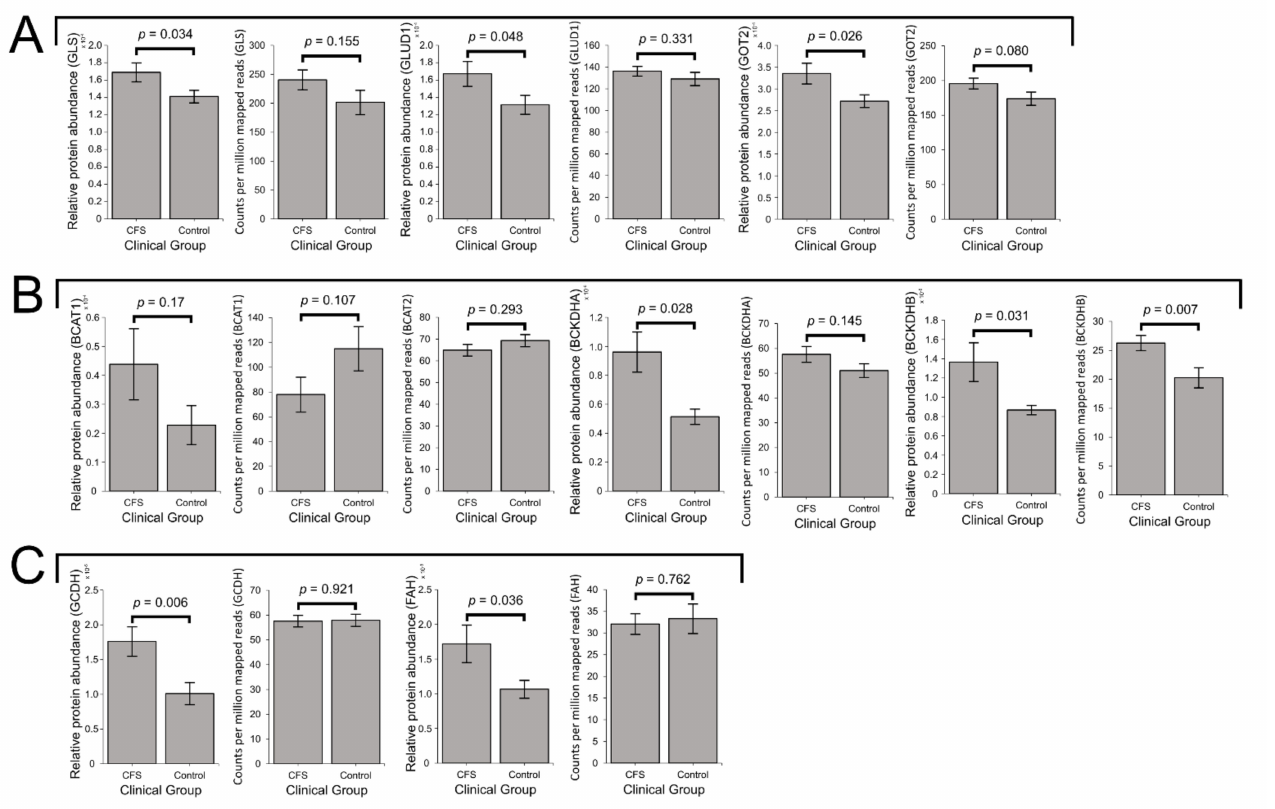
Figure 7. Expression of proteins involved in mitochondrial glutamine, BCAA, lysine, tryptophan and phenylalanine utilisation are elevated in ME/CFS lymphoblasts. Error bars represent the standard error of the mean. RNA sequencing transcriptomics experiment: ME/CFS n = 23, control n = 17. Each cell line was sampled once. Mass spectrometry proteomics experiment: ME/CFS n = 34, control n = 31. Each cell line was sampled once, or twice for a subset of healthy controls arbitrarily selected to act an internal control between experiments in the mass spectrometry proteomics work. ( A ) Expression of the three enzymes mediating mitochondrial utilisation of glutamate (GLS, GLUD1 and GOT2) were elevated in the whole-cell proteomes and proteomes of ME/CFS lymphoblasts and control lymphoblasts ( t test, p < 0.05 in all three cases), while each trended upwards but were not significantly elevated at the transcript level. Relative protein abundance was obtained from Intensity-Based Absolute Quantitation values normalised to the control average within the respective individual experiments. Counts per million mapped reads were calculated for each gene transcript. ( B ) In ME/CFS lymphoblasts, the expression of BCAT1 is unchanged at the protein and transcript levels, while BCAT2 was unchanged transcriptionally and not detected at the protein level. The levels of BCKDH subunits BCKDHA and BCKDHB are both significantly elevated at the transcriptional and protein levels ( t test, p < 0.05), with the exception of BCKDHA transcripts. Relative protein abundance was obtained from Intensity-Based Absolute Quantitation values normalised to the control average within the respective individual experiments. Counts per million mapped reads were calculated for each gene transcript ( C ) The expression levels of GCDH and FAH were unchanged at the transcriptional level but elevated at the protein level ( t test, p < 0.05) in ME/CFS lymphoblasts. Relative protein abundance was obtained from Intensity-Based Absolute Quantitation values normalised to the control average within the respective individual proteomics experiments. Counts per million mapped reads were calculated for each gene